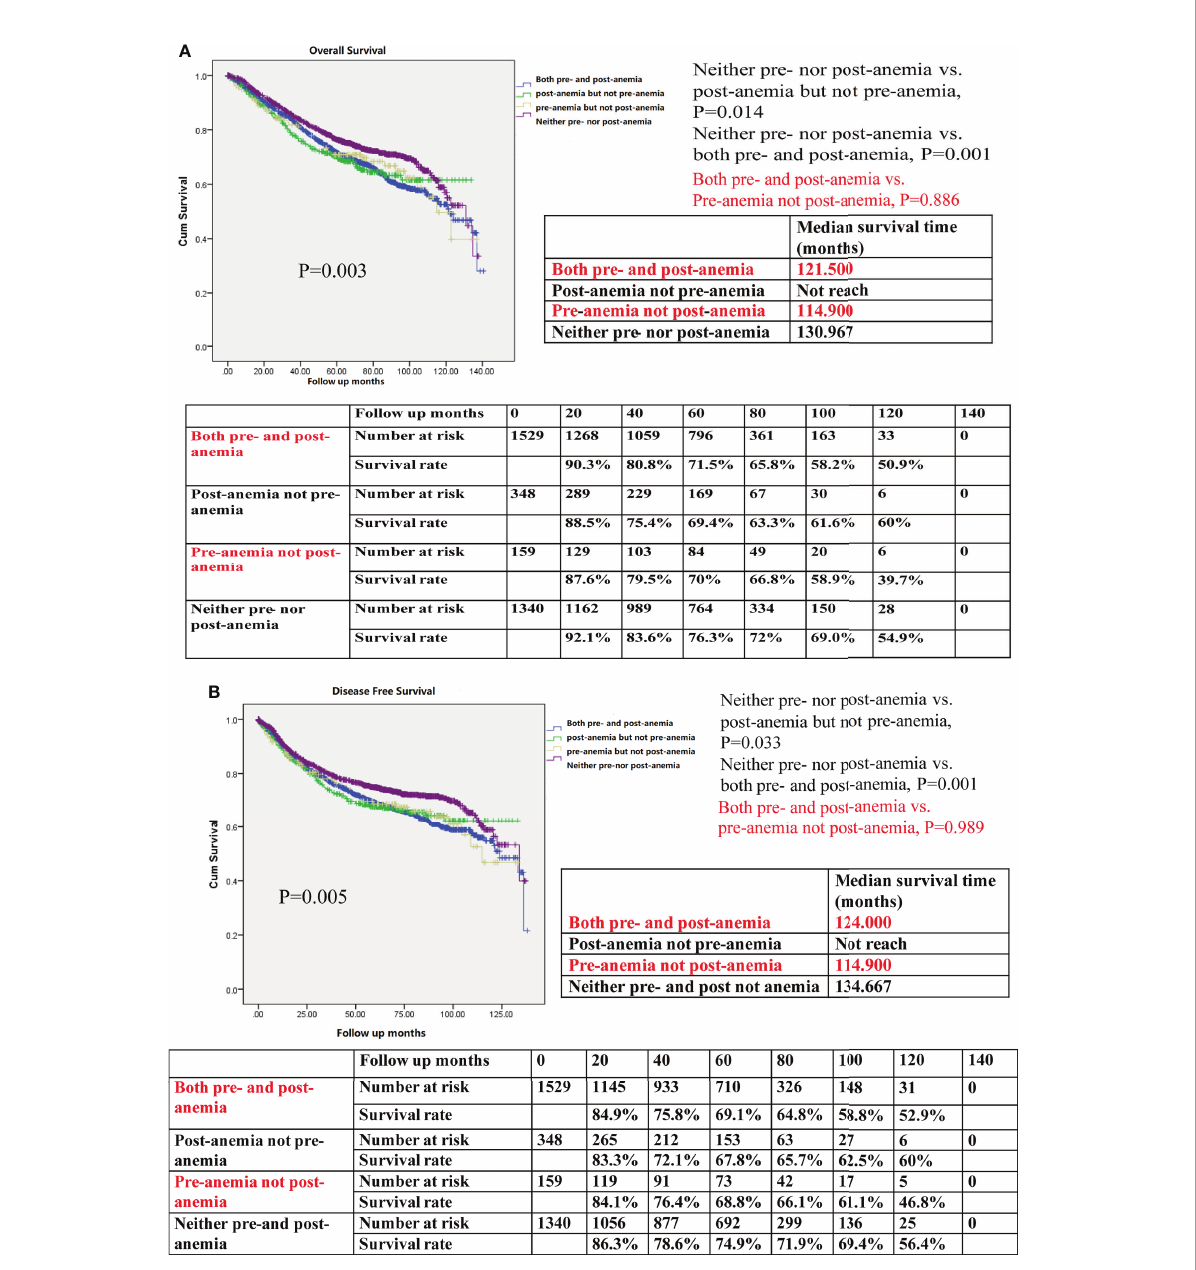
FIGURE 4 (A) Kaplan – Meier survival curve for overall survival (OS) for both preoperative anemia (pre-anemia) and postoperative anemia (post-anemia), post-anemia but not pre-anemia, pre-anemia but not post-anemia, and neither pre- nor post-anemia in the propensity score-matched cohort. The OS rates, median survival time, and number at risk are shown. (B) Kaplan – Meier survival curve for disease-free survival (DFS) for both pre- and post-anemia, post-anemia but not pre-anemia, pre-anemia but not post-anemia, and neither pre- nor post-anemia in the propensity score-matched cohort. The DFS rates, median survival time, and number at risk are shown. The median survival time refers to the corresponding survival time when the survival rate is 50%. “ not reach ” means when a line is drawn vertically on the Y axis 0.5, it does not intersect with the survival curve. There is no corresponding survival time here. Signi fi cance with P <